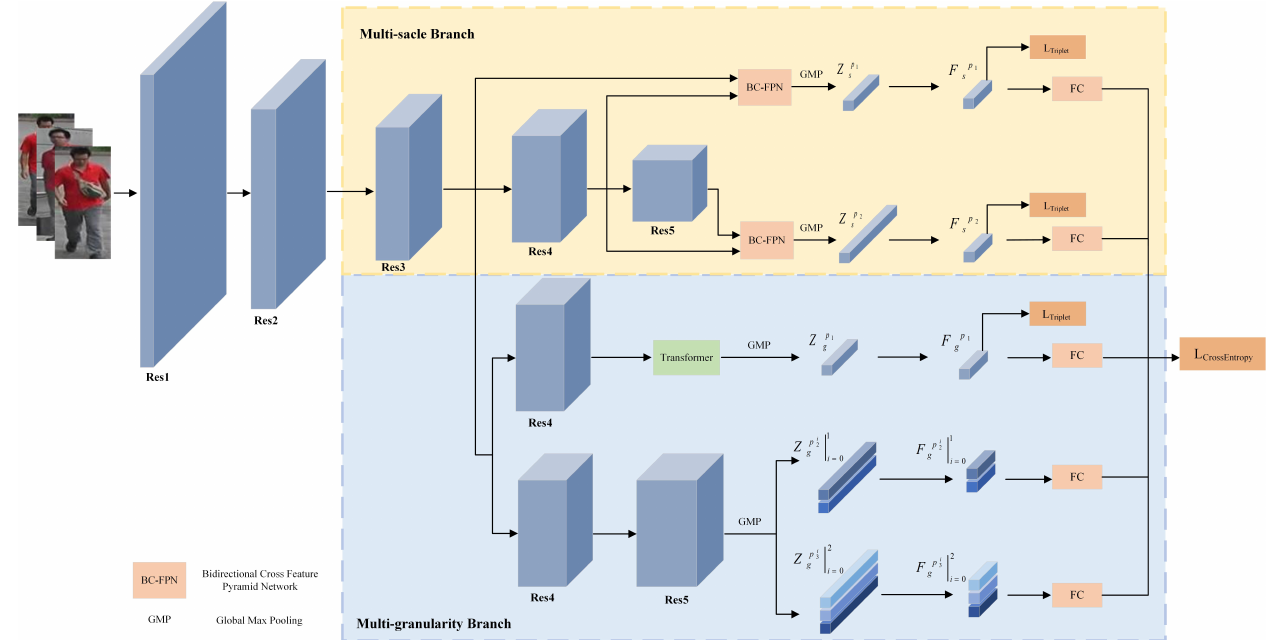
Figure 1. Network structure of this